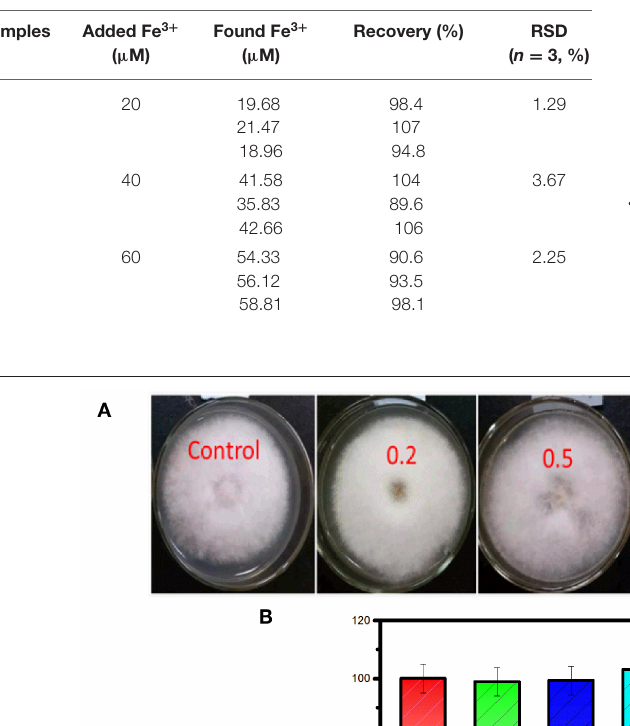
Frontiers in Chemistry |